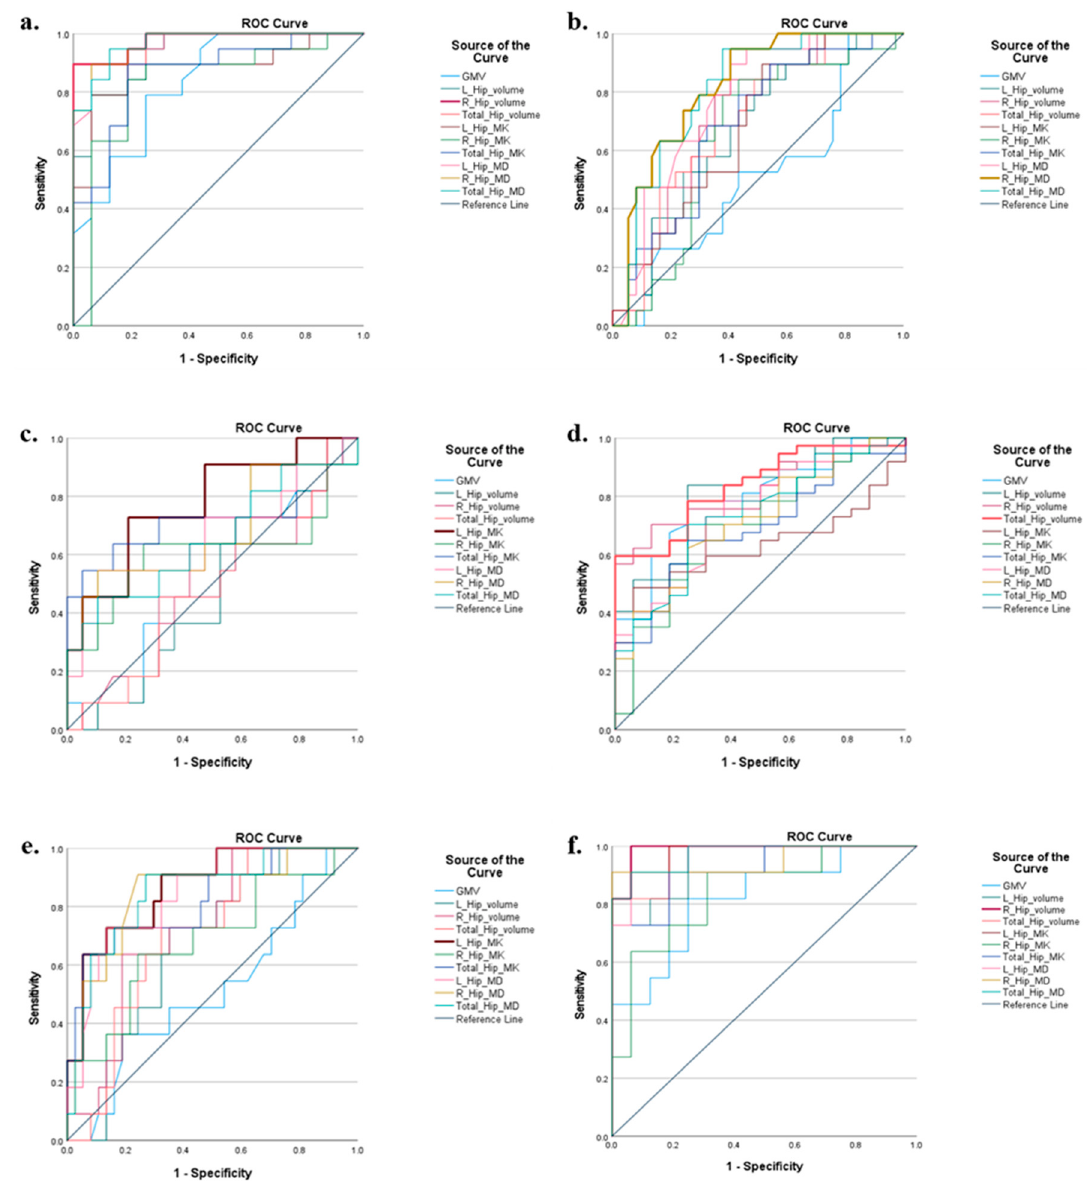
Figure 6. ROC curve for each pair-wise comparison. The statistical software SPSS (version 27) was